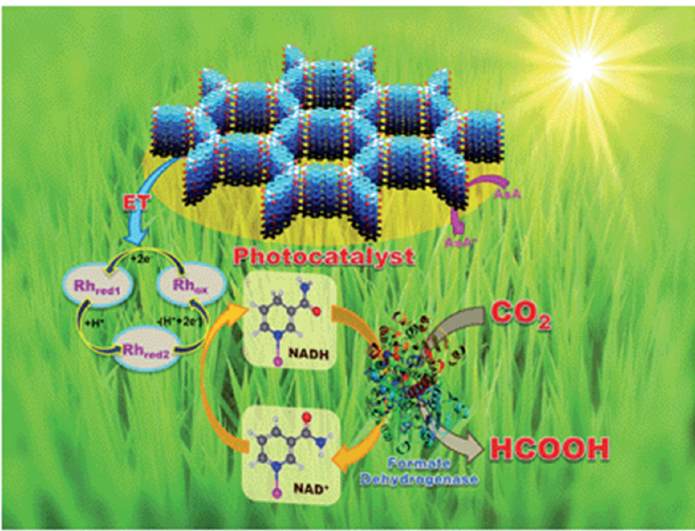
Figure 12. Schematic illustration of the CTF film photocatalyst-enzyme coupled system involved in the exclusive production of formic acid from CO 2 . Rh ox = [Cp * Rh(bpy)H 2 O] 2+ , Rh red1 = Cp * Rh(bpy), Rh red2 = [Cp * Rh(bpy)H] + ; Cp* = pentamethylcyclopentadienyl, bpy = 2,2′-bipyridine. Copied with permission from RSC 2016 [44]. Molecules 2020 , 25 , x